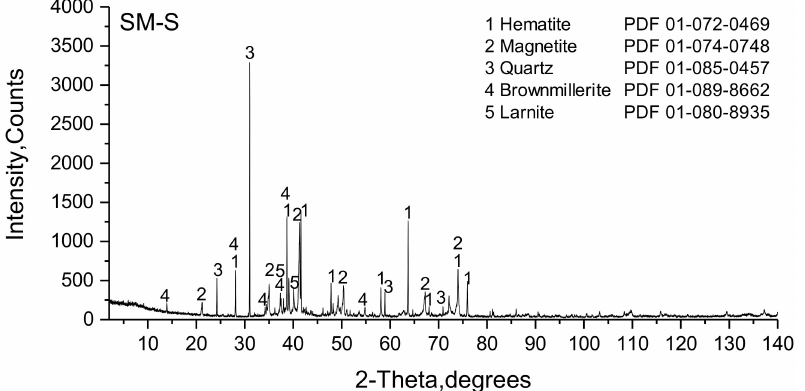
Figure 14. Powder diffractogram of the SM-S sinter.